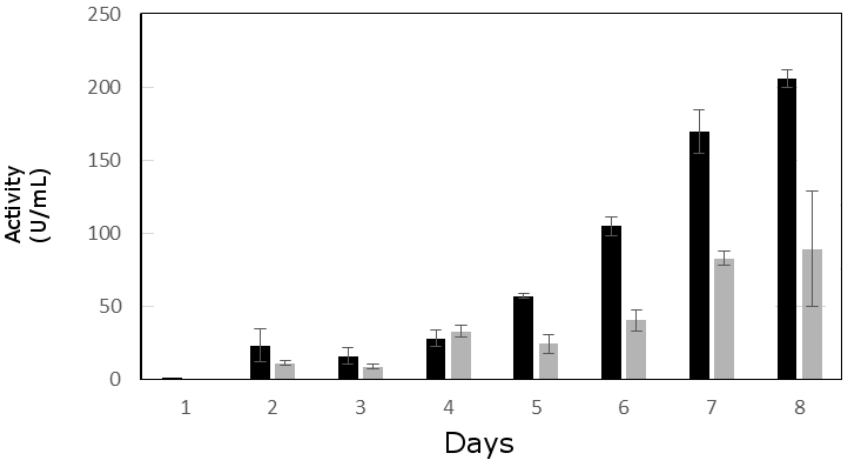
Figure 1. Extracellular lipolytic activity measured with p -nitrophenol palmitate. Black bars show the activity in the strain B13-1; gray bars show the activity in the strain B13-3. The data show the standard deviation of three independent samples.